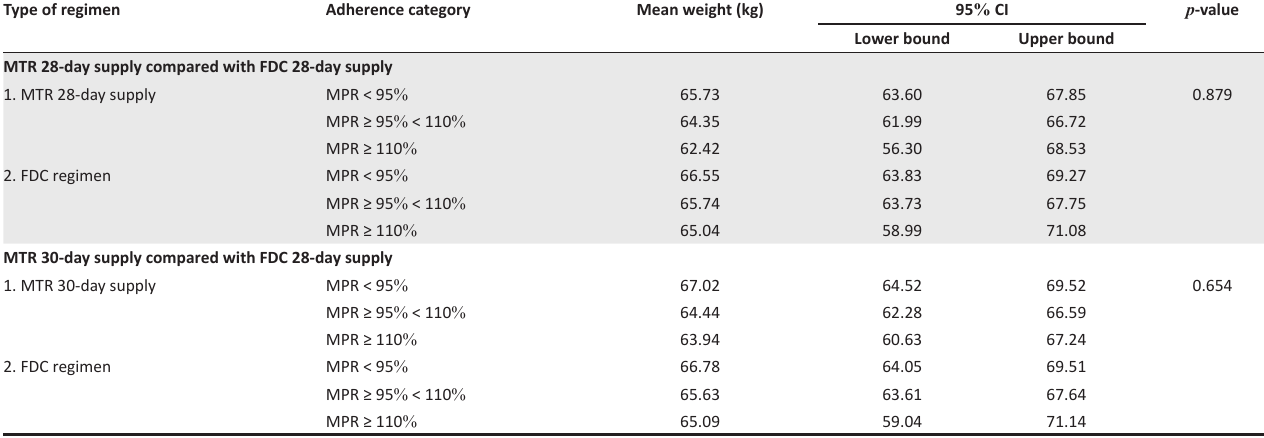
TABLE 3: The effect of regimen type and adherence categories on weight. Type of regimen